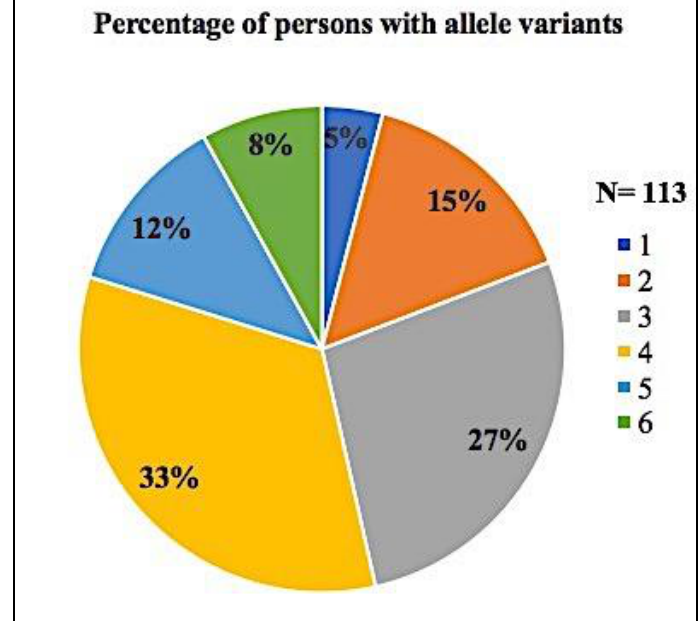
Figure 1. Percentage of subjects with variant alleles.